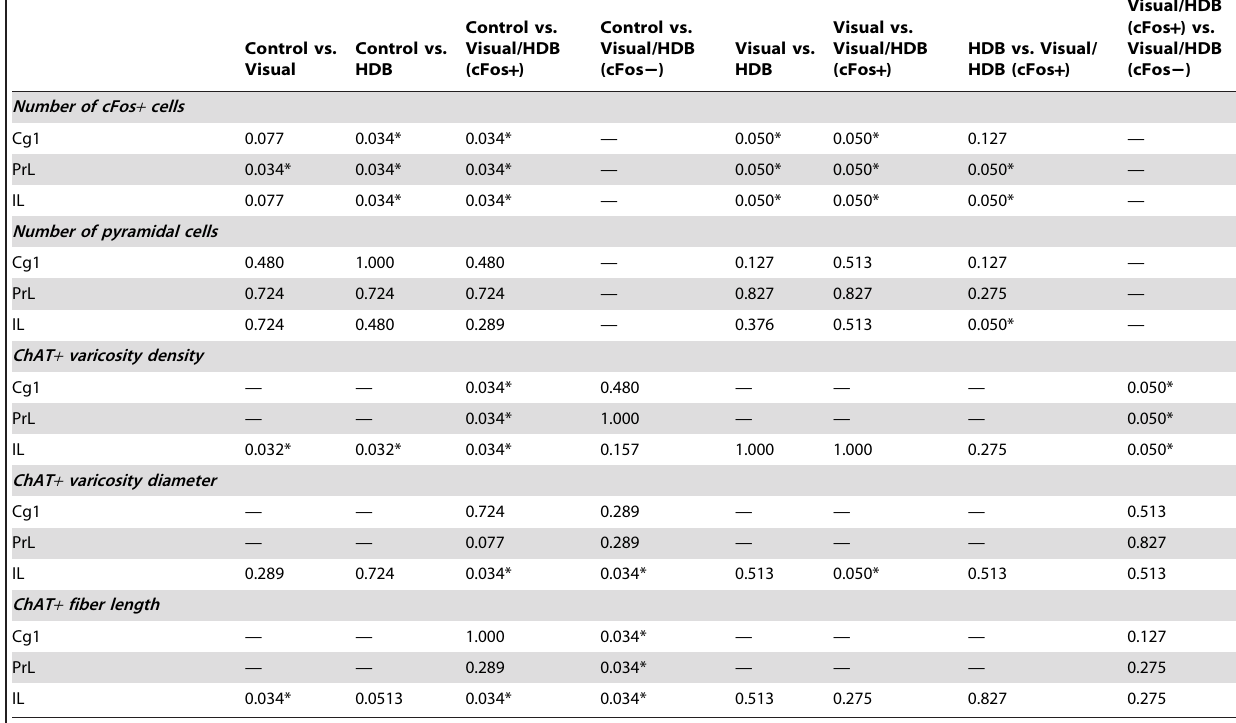
Table 3. p values of group-specific effects.